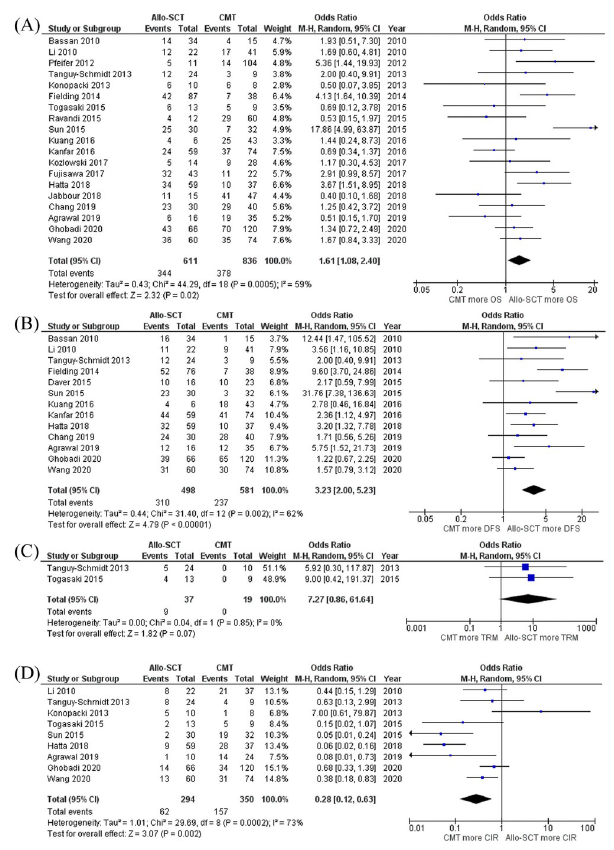
Fig 2. Forest plot of the meta-analysis of allo-HSCT versus CMT only. (A) OS rate (B) DFS rate (C) TRM rate (D) CIR rate. Abbreviations : Allo-SCT Allogenic stem cell transplantation, CIR Cumulative incidence of relapse, CMT Chemotherapy alone, DFS Disease-free survival, OS Overall survival, TRM Treatment-realated mortality.